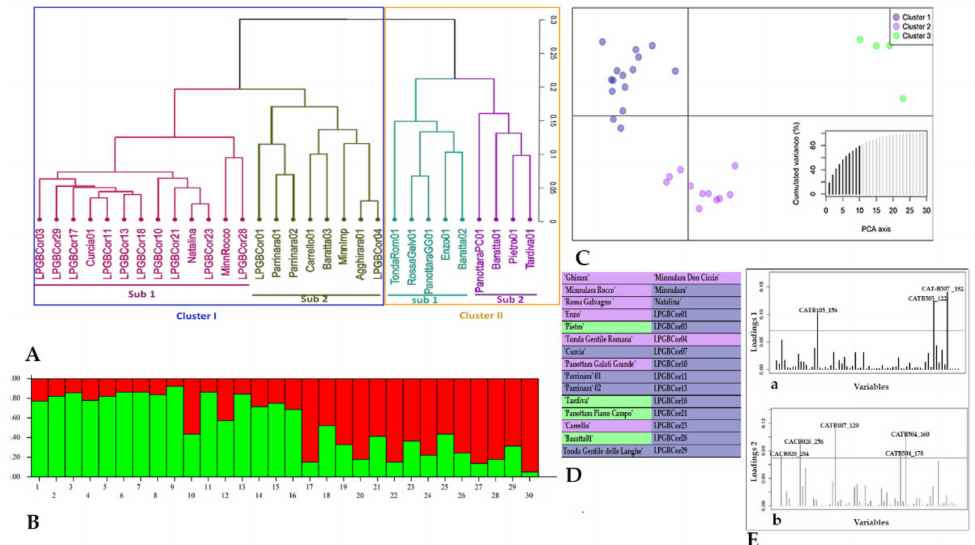
Figure 2. ( A ) UPGMA dendrogram based on Bruvo’s distance coefficient. ( B ) STRUCTURE analysis of 30 Sicilian hazelnut genotypes, using K-values for two groups. STRUCTURE plot showing the proportion of inferred ancestry (Q) in the genetic clusters identified within 30 genotypes. ( C ) Discrim- inant analysis of principal components (DAPC). Dots represent individuals, and the scatterplot shows only the first two PCs of the DAPC analysis. ( D ) Group memberships of DAPC represented with the cluster colors. ( E ) Contribution of alleles to the first (a) and the second (b) principal components of DAPC. The height of each bar is proportional to the contribution of the corresponding allele to the first and second principal components of the analysis, respectively. Only alleles whose contribution was above a threshold (gray horizontal line) are indicated for the sake of clarity. Table 2. The STRUCTURE results of 30 hazelnut genotypes for inferred cluster, the fixation index (Fst), average distances (expected heterozygosity), and number of genotypes assigned to each cluster. Expected Number of Cluster Inferred Cluster Mean Fst Heterozygosity Accessions I 0.460 0.0016 0.8247 13 II 0.540 0.4482 0.5166